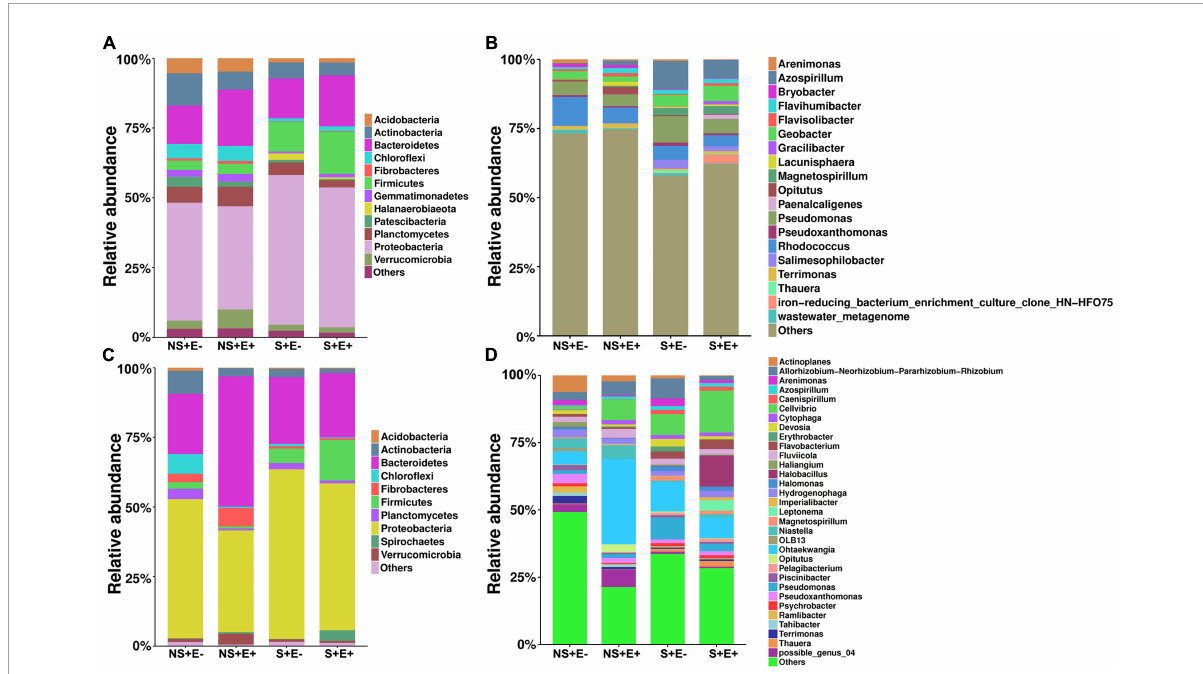
FIGURE6 The relative abundance (at the phylum and genus level) of rhizosphere soil (A,B) and root (C,D) bacteria community under E. ludwigii B30 infection treatment and salt stress. ( n = 3; “NS + ” represents bermudagrass grown without NaCl condition; “S + ” represents bermudagrass under 250 mM salt conditions. “E + ” represents the infection of E. ludwigii B30, “E–” represents the absence of E. ludwigii